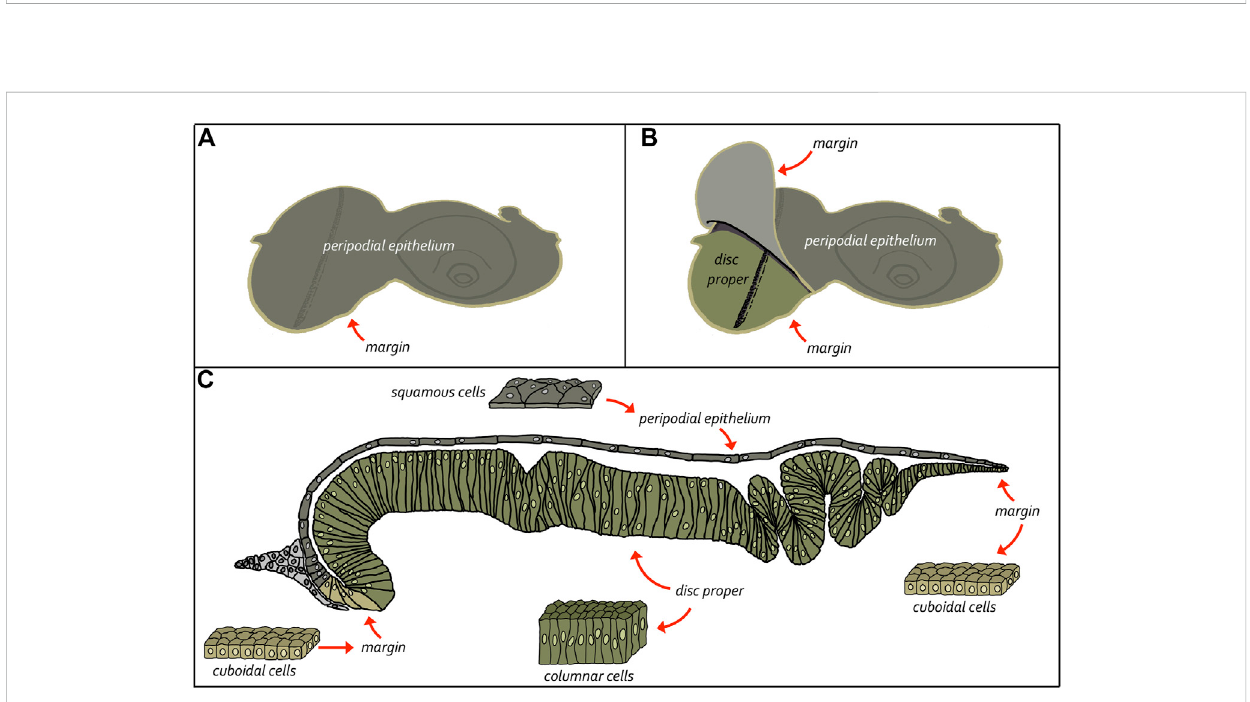
FIGURE 8 Structure of the eye-antennal disc. The eye-antennal disc is comprised of three different cell types. A layer of columnar cells comprises the disc properwhilean overlyinglayer ofsquamous cellsmakesup theperipodialepithelium.Thesetwoequally sizedtissues arejoined togetherattheedgesby a strip of cuboidal cells referred to as the margin. (A, B) Schematics showing the relationship between the disc proper and the peripodial epithelium. (C) Cross-section view of the eye-antennal disc showing the relative position of all three layers and the enclosed lumen. It also shows the cellular composition of the three cellular